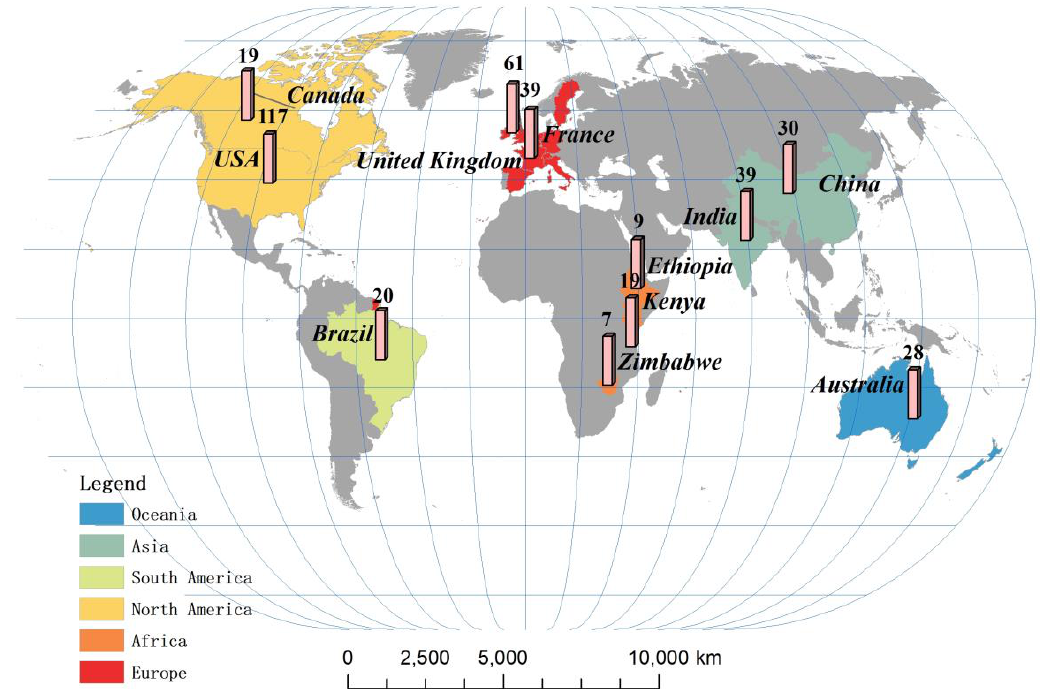
Figure4. Visualizationofthegeographicaldistributionofliteraturesonglobalsustainableintensification Figure 4. Visualization of the geographical distribution of literatures on global sustainable practices. Data source: Web of Science Core intensification practices. Data source: Web of Science Core Collection.